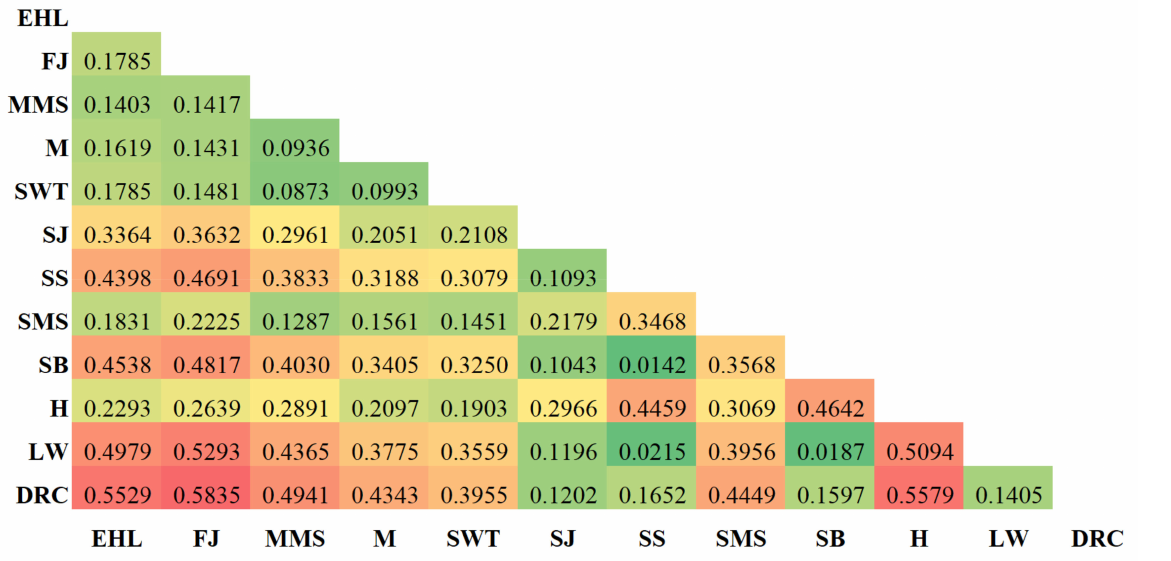
Figure 3. Heatmap of the fixation indices ( F st) between 12 pig population including seven Jiangsu pig population. The color from red to green indicted that the FST value was decreased. EHL, Erhualian; FJ, Fengjing; MMS, Middle Meishan; M, Mi; SWT, Shawutou; SJ, Sujiang; SS, Sushan; SMS,